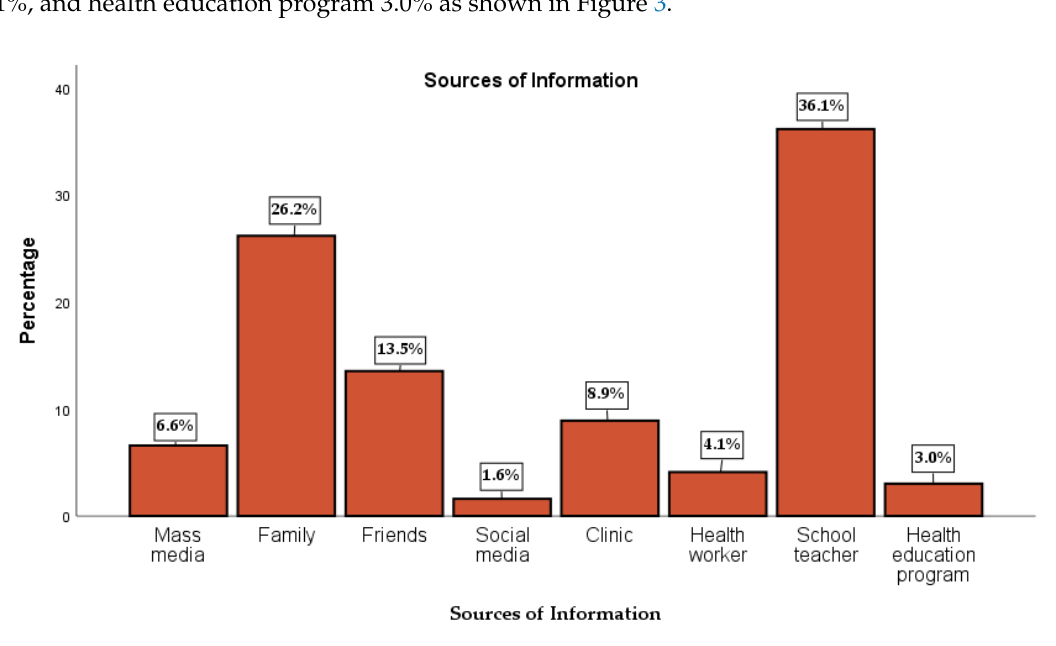
Figure 3. Respondents Regular Sources of Nutritional Information.